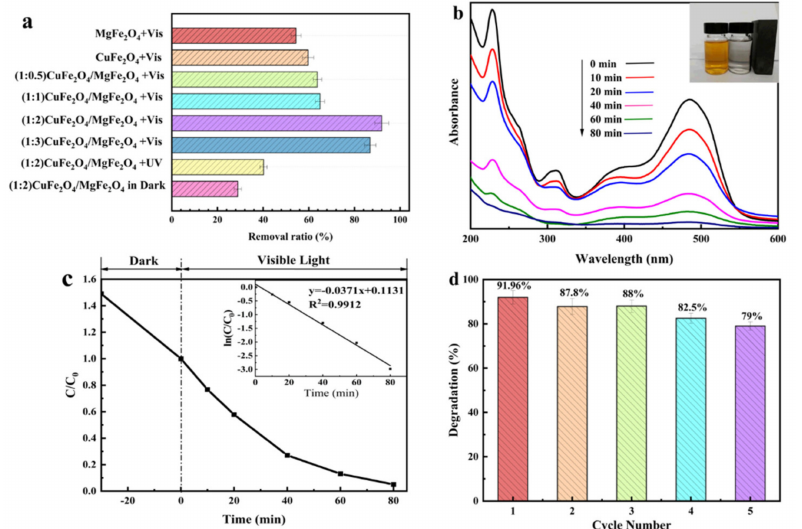
Figure 6. ( a ) Effects of different Cu:Mg ratios on the degradation of AO 7 ; ( b ) time-dependent UV–vis spectra of the AO 7 solution for (Cu:Mg = 1:2) CuFe 2 O 4 /MgFe 2 O 4 ; ( c ) dark adsorption and pho- todegradation curves of the AO 7 solution and pseudo-first-order reaction kinetic linear relationship curve (insert; catalyst 0.8 g/L, AO 7 = 0.10 mM); ( d ) reusability of (Cu:Mg = 1:2) CuFe 2 O 4 /MgFe 2 O 4 for 5 successive